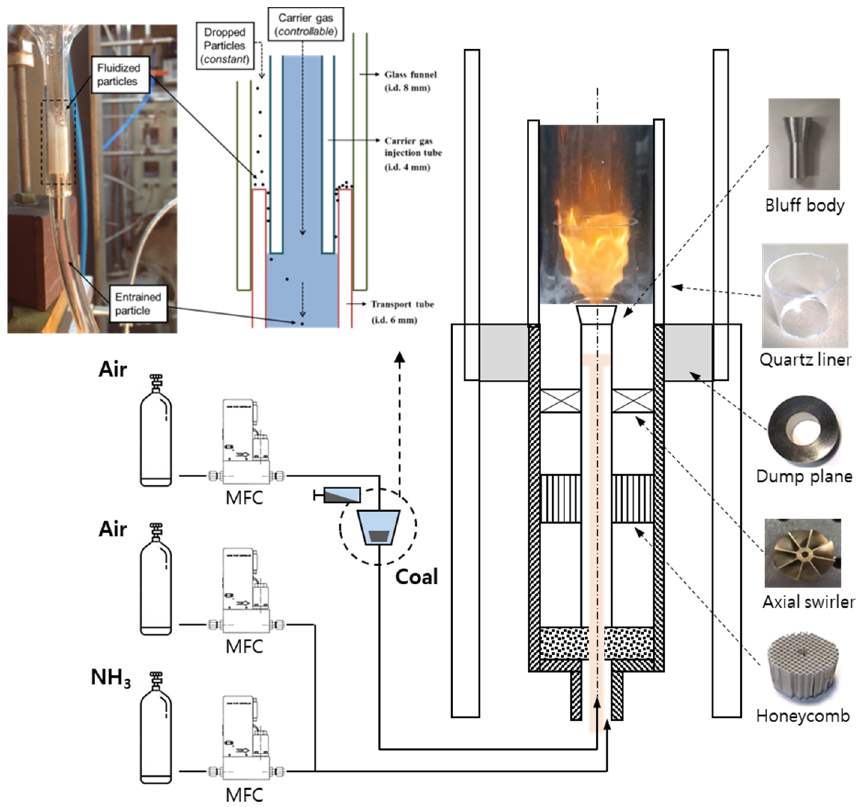
Figure 29. Experimental apparatus for NH 3 -air and NH 3 -coal-air combustion.